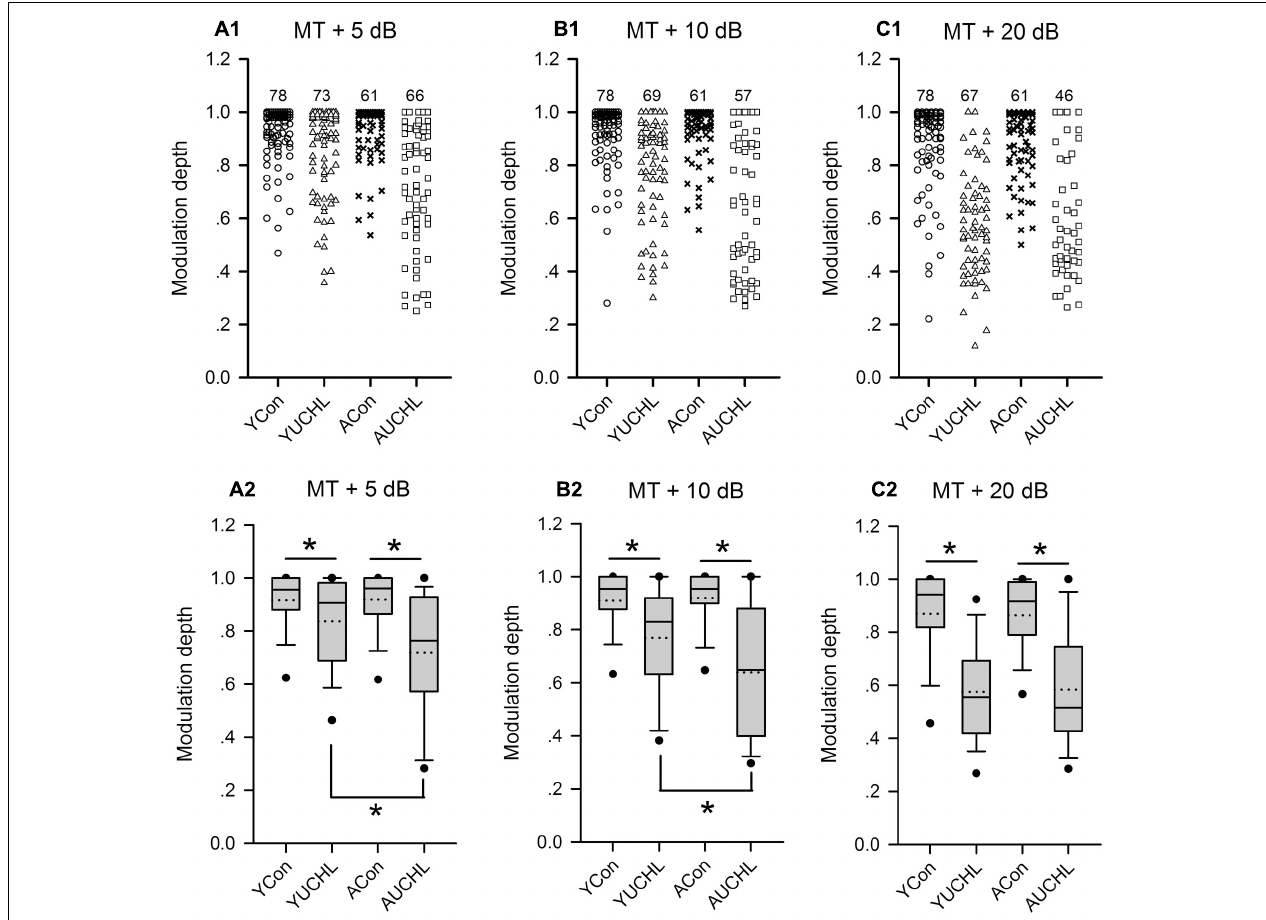
FIGURE 8 | Comparison of the modulation depth of the azimuth functions of AI neurons among the four groups of rats. For each panel, the x -axis indicates four different groups of rats, and the y -axis represents the value of the modulation depth. MT + 5 dB, MT + 10 dB, and MT + 20 dB are the sound levels used to determine the azimuth functions of AI neurons. (A1–C1) The data of modulation depth for each group determined at the tested sound levels, and the number on the top of the symbols for each group is the number of neurons included. (A2–C2) The box plots showing the comparison of the modulation depth for the population AI neurons in the four groups of rats. The plots show the median (solid line in each box), mean (dotted line in each box), quartiles (box extremities), 10th/90th percentiles (error bars), and 5th/95th percentiles (filled circles). ∗ indicates significant difference in modulation depth between the two groups (Mann–Whitney test, p < 0.05).